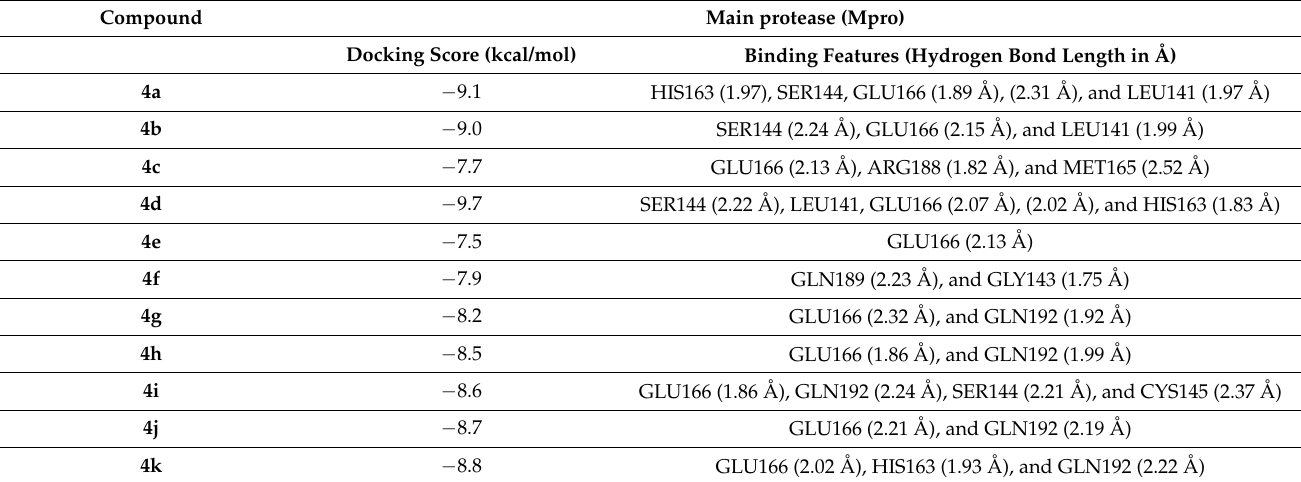
Table 5. Docking tests in (kcal/mol) and estimated binding properties for compounds 4a–4k with SARS-CoV-2 main protease were